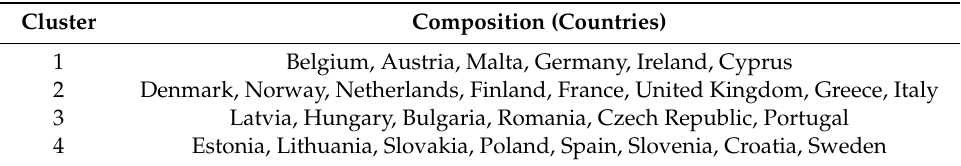
Table 7. Cluster composition.